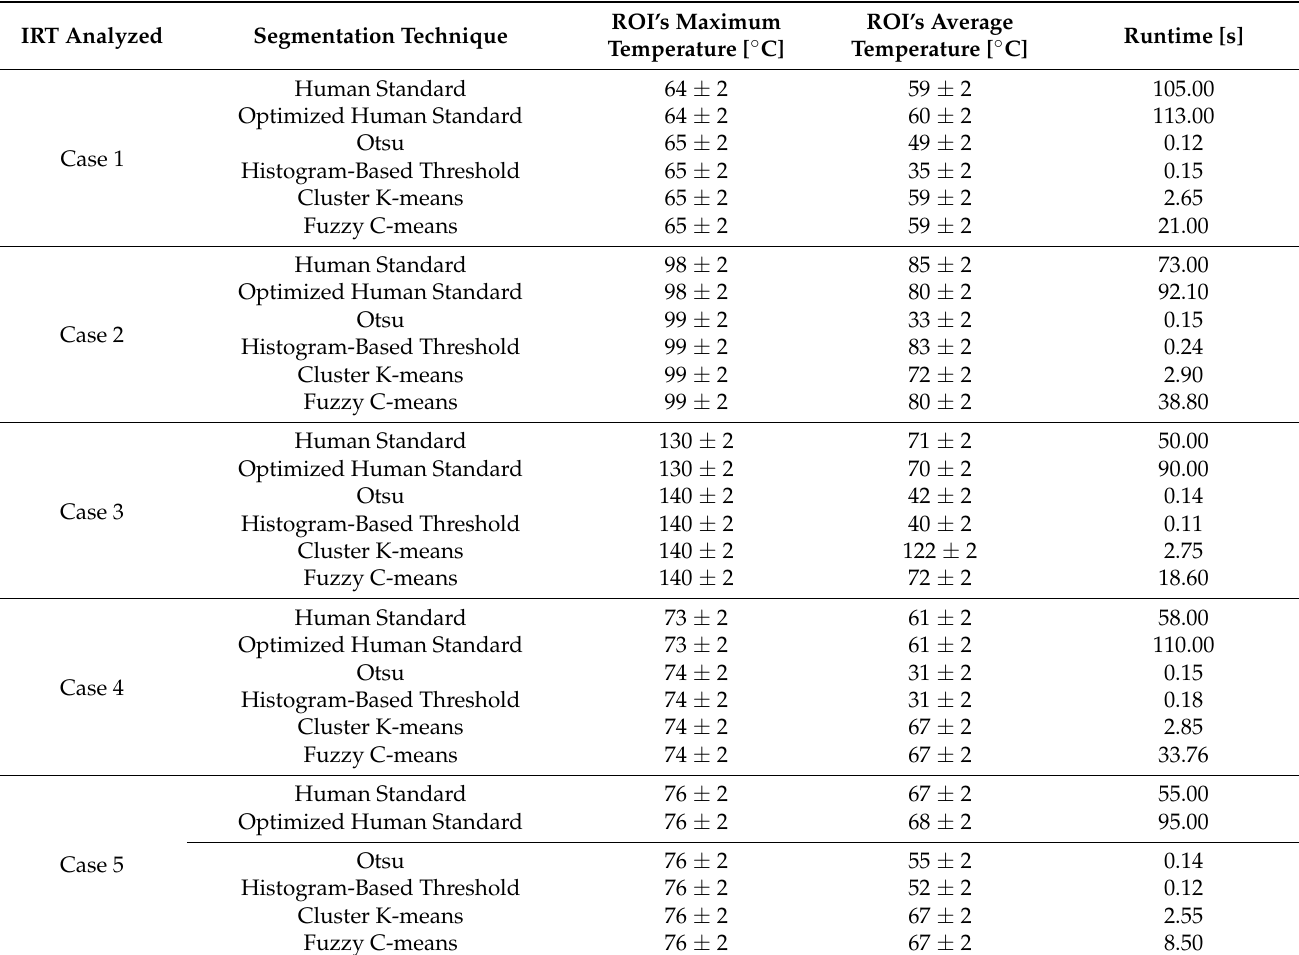
Table 2. Maximum and average temperatures of the segmented ROI of the analyzed cases and the runtime of each